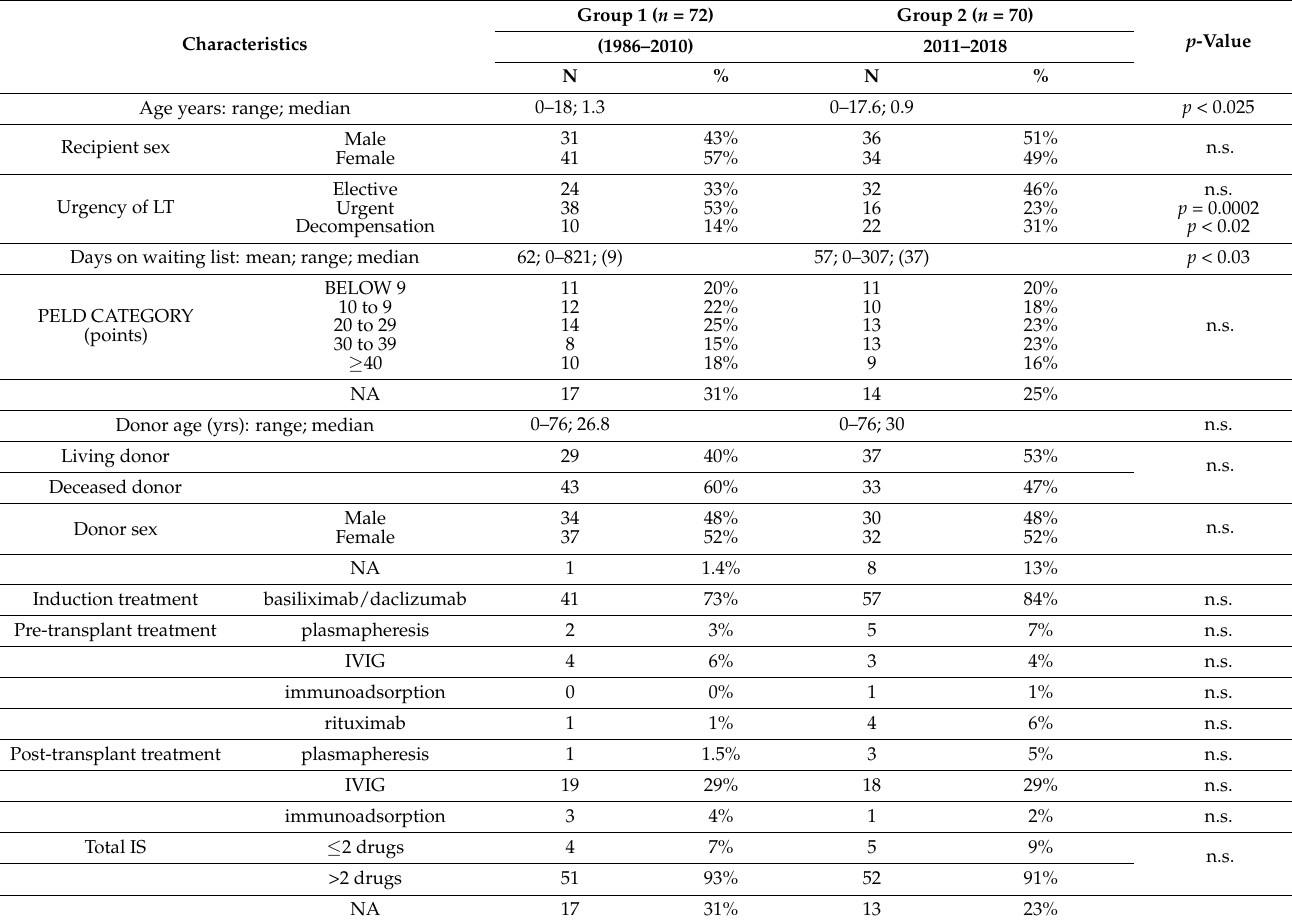
Table 4. Characteristics of 72 pts transplanted before 2011 (Group 1) and 70 pts transplanted since 2011 (Group 2). Data corrected for availability (removal of missing